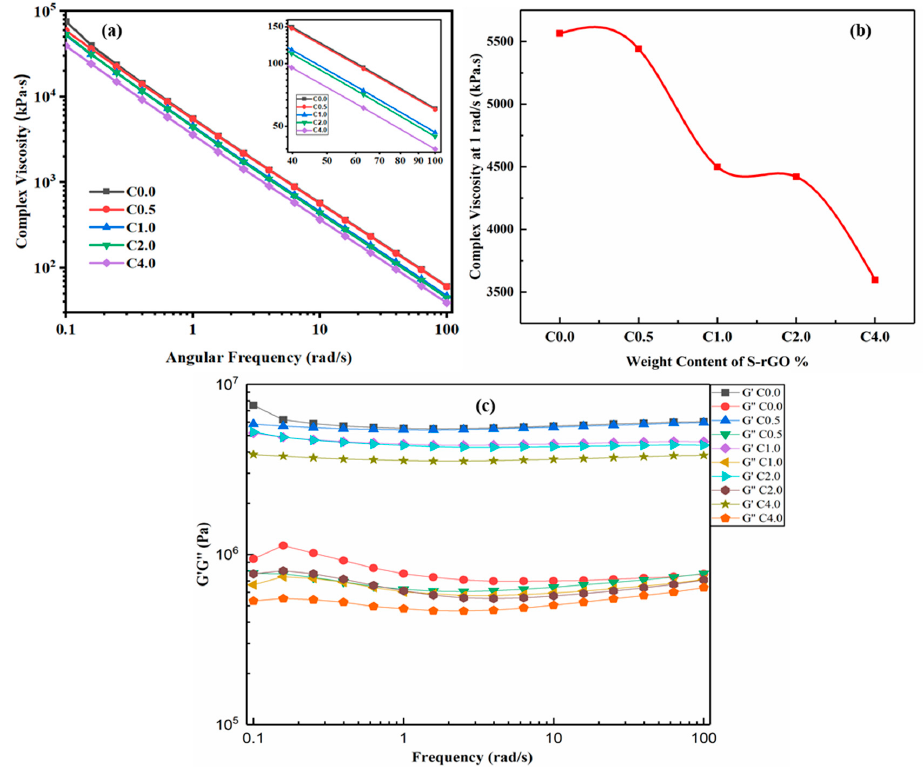
Figure 5. Rheological properties of the experimental composites (C0.0—C4.0) at 25 °C. ( a ) Complex viscosity vs angular frequency (Inset is a magnified view of the complex viscosity) ( b ) complex viscosity vs S-rGO wt.% at 1 rad/s ( c ).